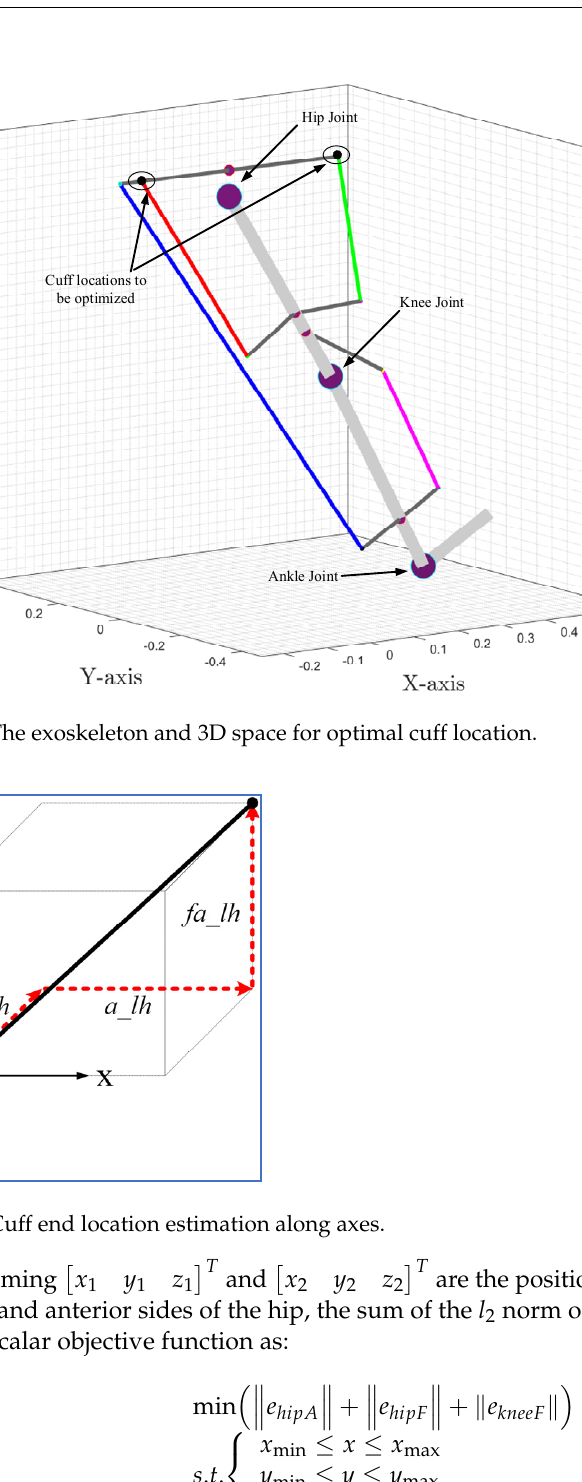
Figure 6. The exoskeleton and 3D space for optimal cuff location.